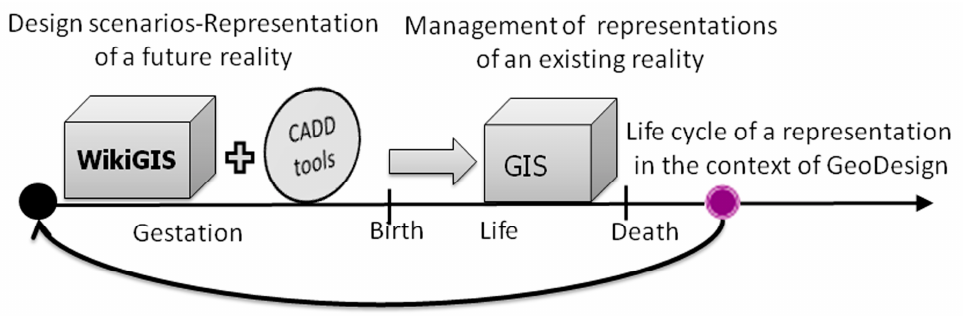
Figure 3. WikiGIS positioning with GIS (Geographic Information System) and CADD (Computer Aided Design and Drafting)